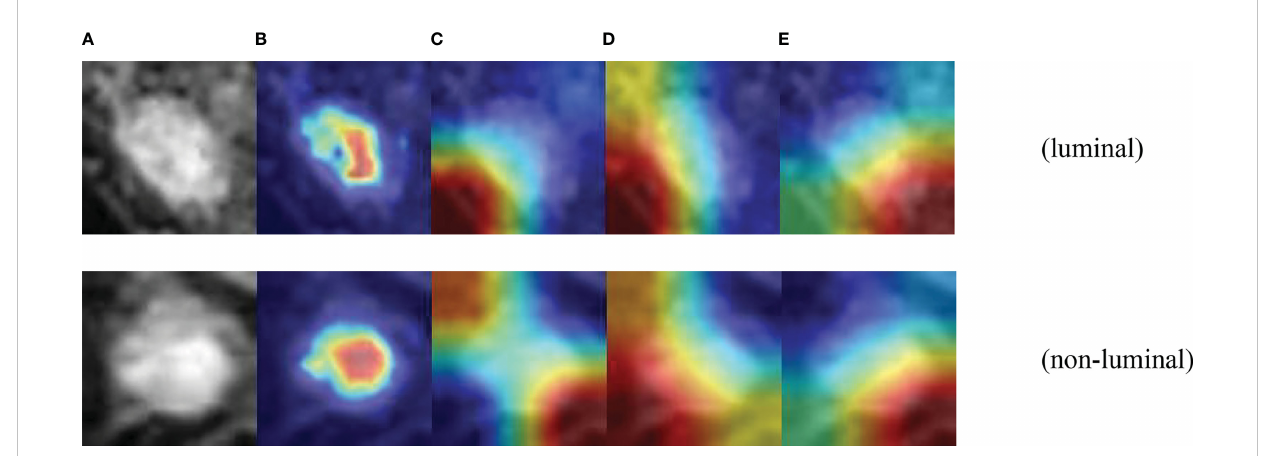
FIGURE 6 Visualization of CAMB CNN. (A) Source images. (B) CAMBNet images. (C) ResNet34 images. (D) DenseNet121 images. (E) Vgg16